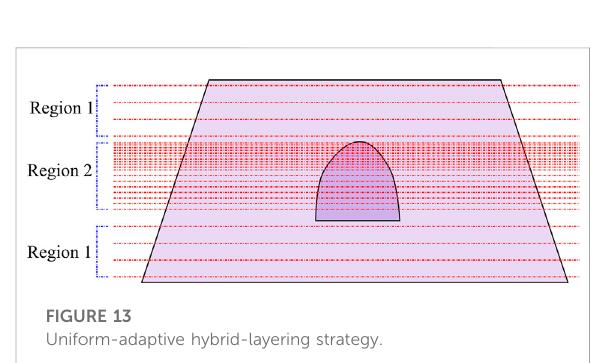
FIGURE 13 Uniform-adaptive hybrid-layering